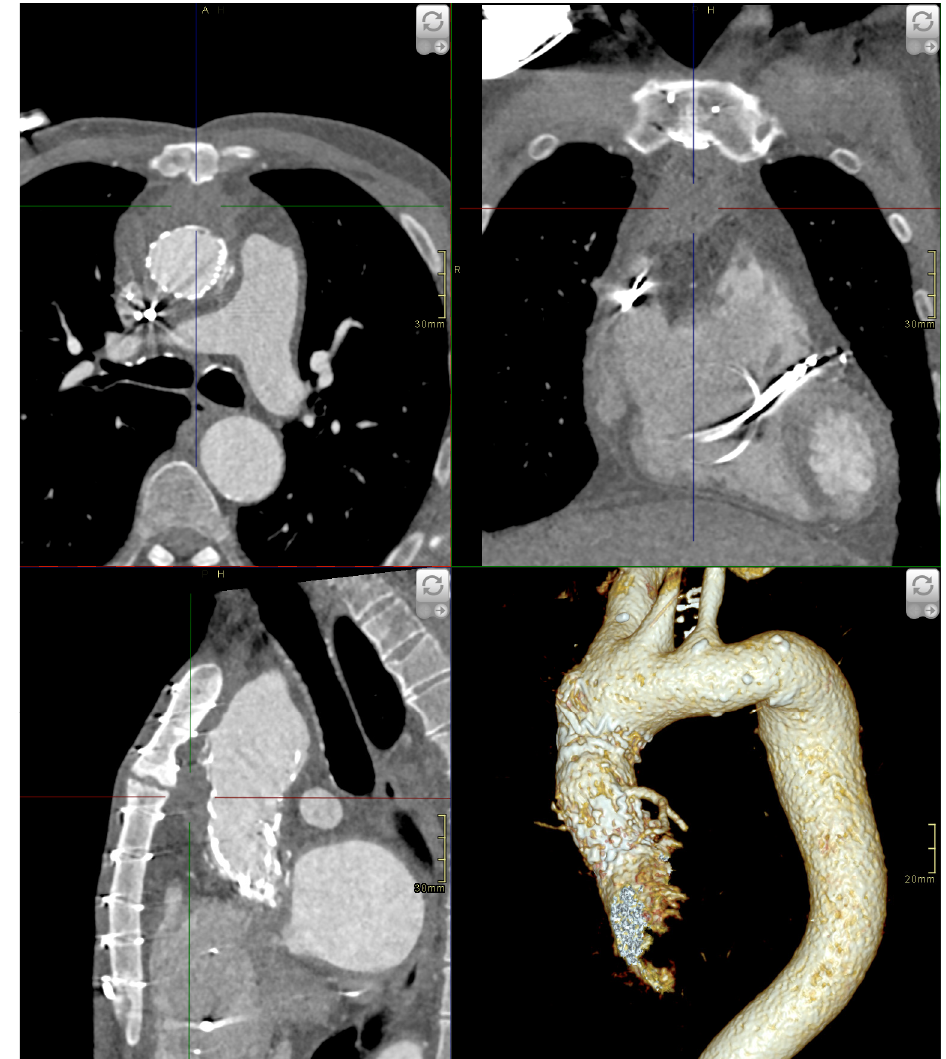
Figure 5. Two months’ follow-up CTA showing complete exclusion of the pseudoaneurysm. Clock- wise from left bottom: sagittal plane arterial phase CTA, axial plane arterial phase CTA, coronal plane arterial phase CTA, volume rendering technique (VRT) 3D representation